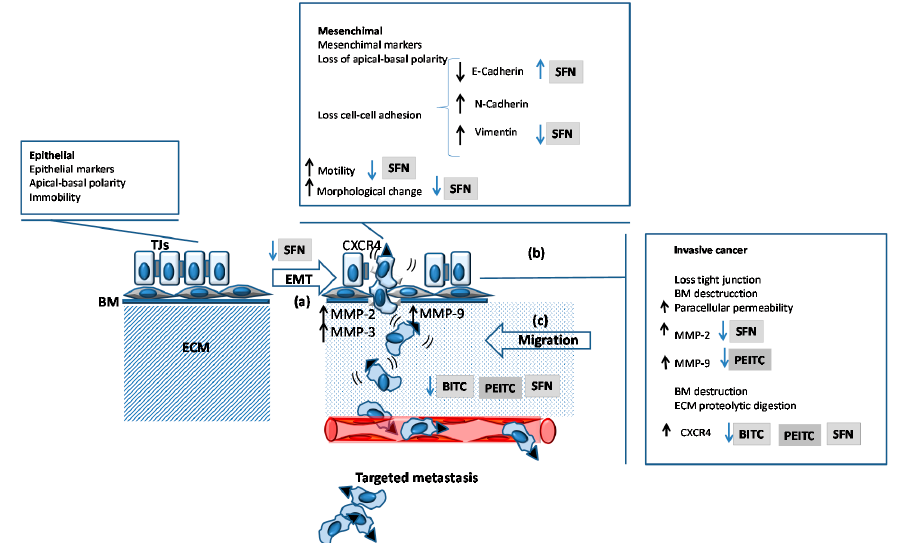
Figure 3. Schematic representation of the inhibitory effects of ITCs on EMT and invasion-metastatic mechanism in PCa cells in vitro . ( a ) During EMT epithelial cells decrease adhesion, change their morphology, polarity and position. EMT is characterized by a dowregulation ( ↓ bold arrow) and upregulation ( ↑ bold arrow) of genes that are characteristic of an epithelial and mesenchymal phenotype, respectively; The invasive ( b ) and migration ( c ) capacities are increased in the cells overexpressing CXCR4, MMP-2, MMP-9, MMP-3 ( ↑ bold arrow). Inhibitory effects of ITCs are represented by blue arrows ( ↑ , enhanced expression, activity or protein levels; ↓ , reduced expression, activity or protein levels). Abbreviations: BITC, benzyl isothiocyanate; BM, basement membrane; CXCR4, chemokine receptor type 4; ECM, extracellular matrix; EMT, epithelial- mesenchymal